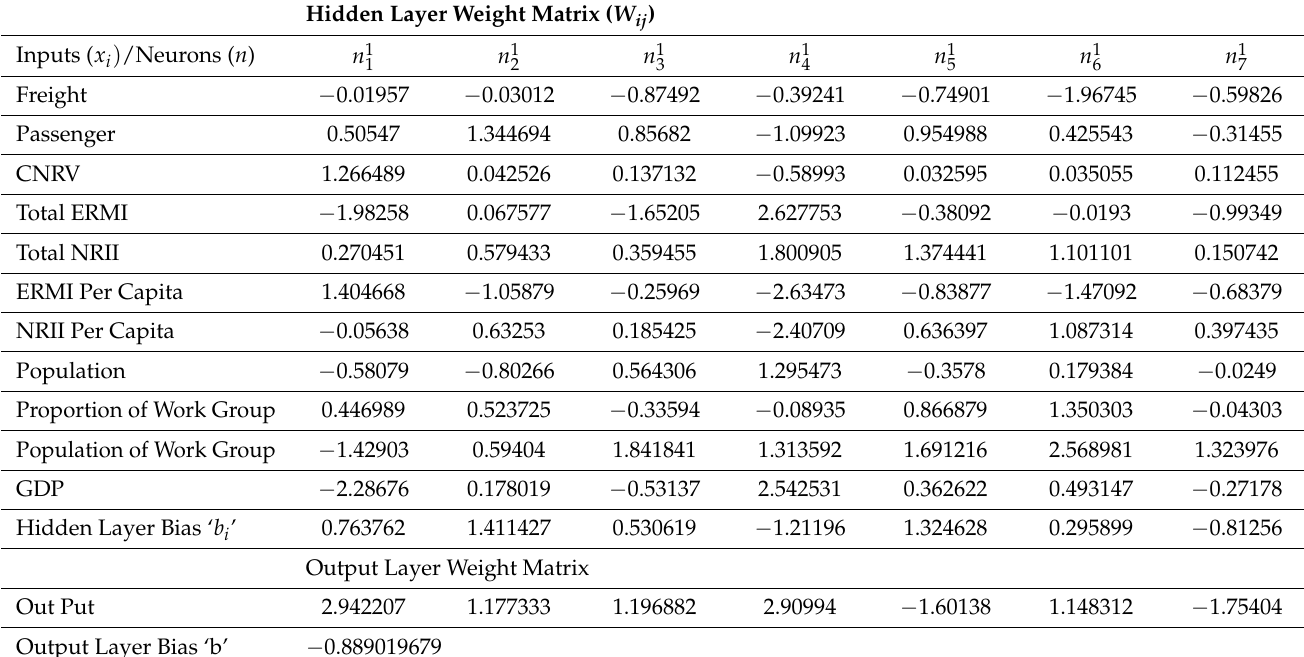
Table 4. Trained ANN model weight and bias matrices.